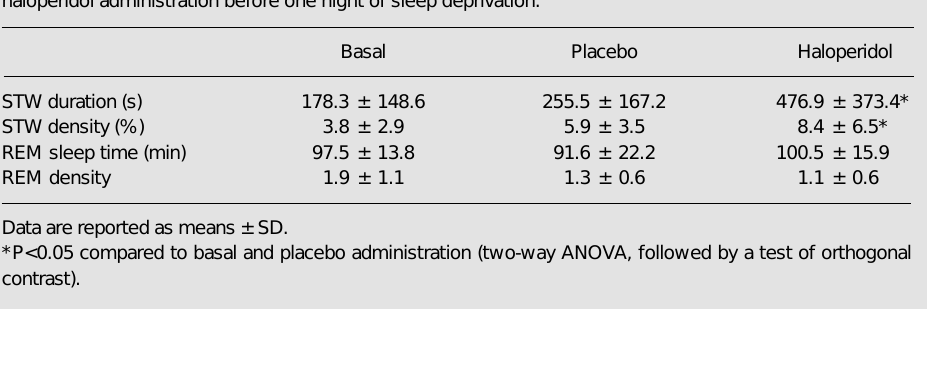
Table 2. Sawtooth wave (STW) duration and density, rapid eye movement (REM) sleep time and REM sleep density observed in 10 volunteers during the basal night and the subsequent recording night after placebo and haloperidol administration before one night of sleep